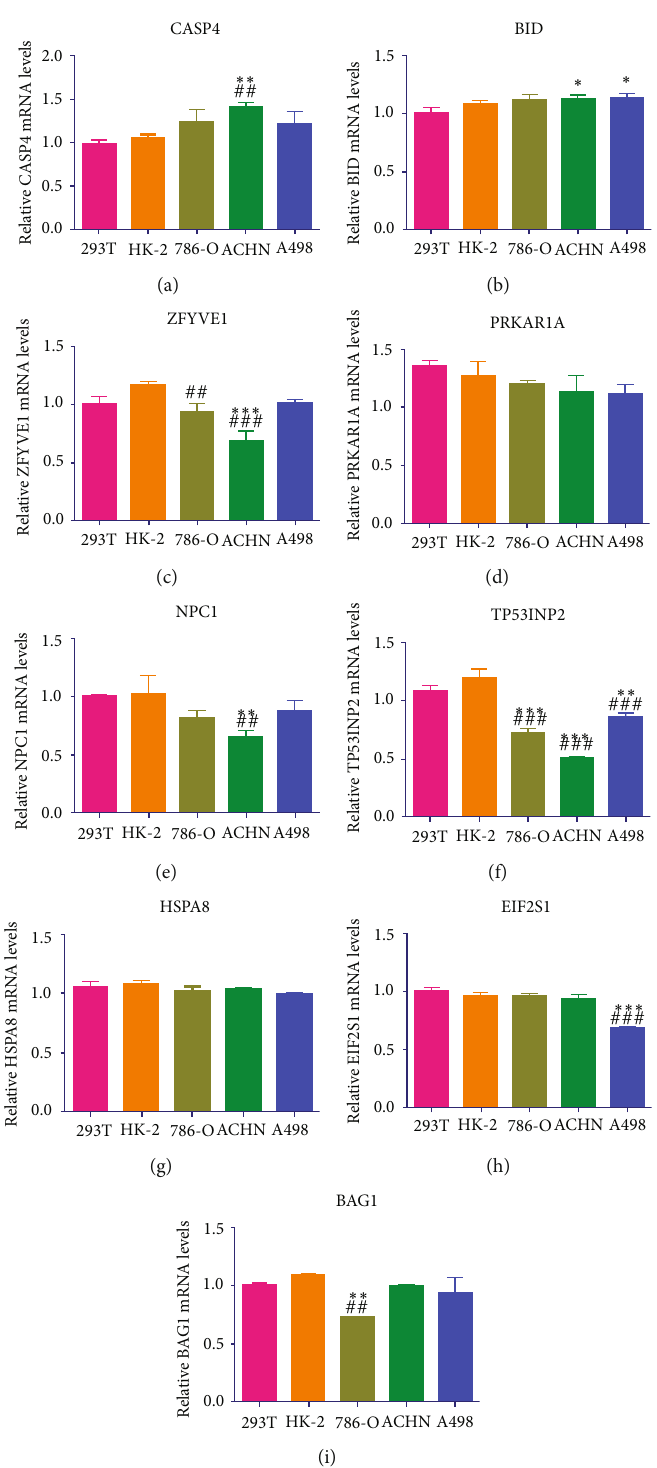
Figure 4: The relative mRNA level of autophagy-related genes BID (a), CASP4 (b), ZFYVE1 (c), PRKAR1A (d), NPC1 (e), TP53INP2 (f), HSPA8 (g), EIF2S1 (h), and BAG1 (i) in ccRCC cell lines was detected by qRT-PCR. Data were shown as mean ± SD of three or four independent experiments. Compared to the 293T group: ∗ P < 0 : 05 ; ∗∗ P < 0 : 01 ; ∗∗∗ P < 0 : 001 ; compared to the HK-2 group: ## P < 0 : 01 , ### P < 0 : 001